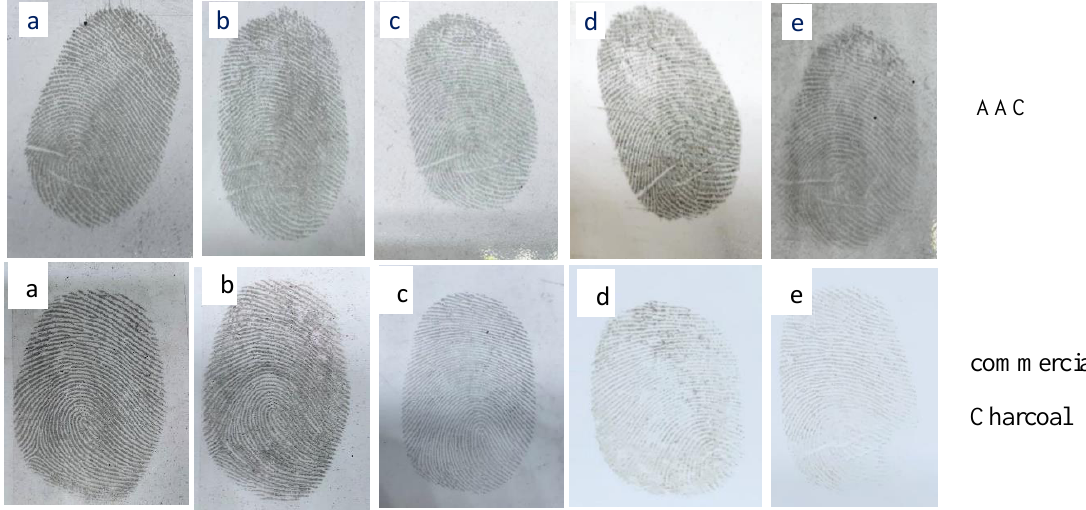
Fig. 10. Comparative visualizations of latent fingerprints for both powders on the nonporous surface(cardboard) at different lifespans. (a) after 1 day. (b) after 4 days. (c) After 7 days. (d) after 15 days. (e) after 25